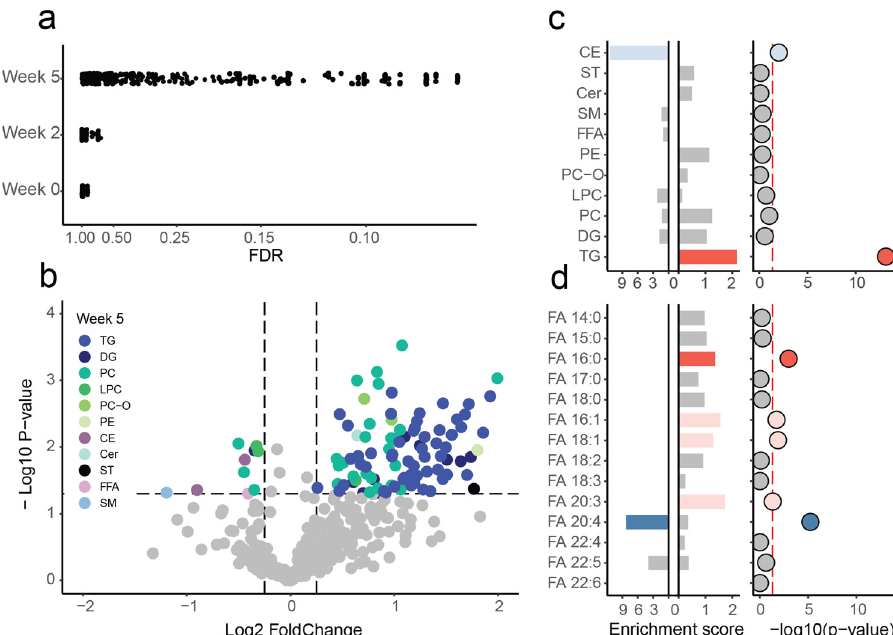
Figure 2. Changes in plasma lipidome detected at 5 weeks post-injury. ( a ) For the three time points, distribution of FDR-corrected p -values for the ANOVA test between NI and CL. Benjamini–Hochberg FDR correction was used for visualization. ( b ) Volcano plot for ANOVA test between NI and CL, with − log10 p -values plotted against the log2 fold change between NI and CL. NI-associated lipids are indicated in color according to lipid class, and the rest are colored in gray. ( c , d ) Enrichment score and − log10 p -values of hypergeometric test for the enrichment of lipid classes ( c ) and fatty acid (FA) residues ( d ) among NI-associated lipids. Analysis was performed separately for NI-associated lipids with increased (right-facing bar plots) and decreased (left-facing bar plots) abundances in NI. Only the lower p -value of the two analyses is indicated for each lipid class and fatty acid residue. Significant enrichment is marked by darker red and blue colors, and marginal enrichment is indicated by lighter shades.